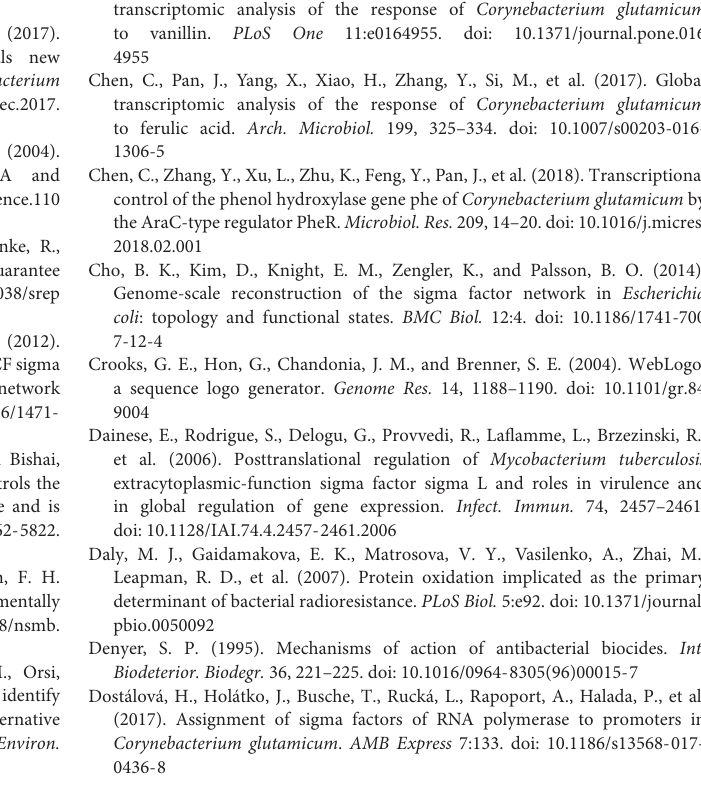
TABLE S1 | Oligonucleotides used. TABLE S2 | List of identified TSSs of SigD-upregulated genes and the respective sequences as detected by RNA-seq of transcriptome of C. glutamicum with overexpressed sigD cultivated on glucose. TABLE S3 | List of identified TSSs of and the respective sequences as detected by RNA-seq of transcriptome of C. glutamicum WT cultivated on glucose. TABLE S4 | List of identified SigD-dependent TSSs of SigD-upregulated genes and the respective sequences as detected by RNA-seq of transcriptome